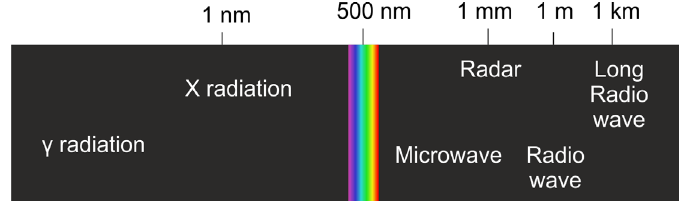
Figure 1. Scheme of the spectrum of electromagnetic radiation. Optical and thermal bands are usually used for closer ranges, whilst radar bands are commonly used for longer ranges. The radar range covers wavelengths from a few milli- meters to several meters and is divided into a number of bands, depending on the prop- agation properties (Table 1).